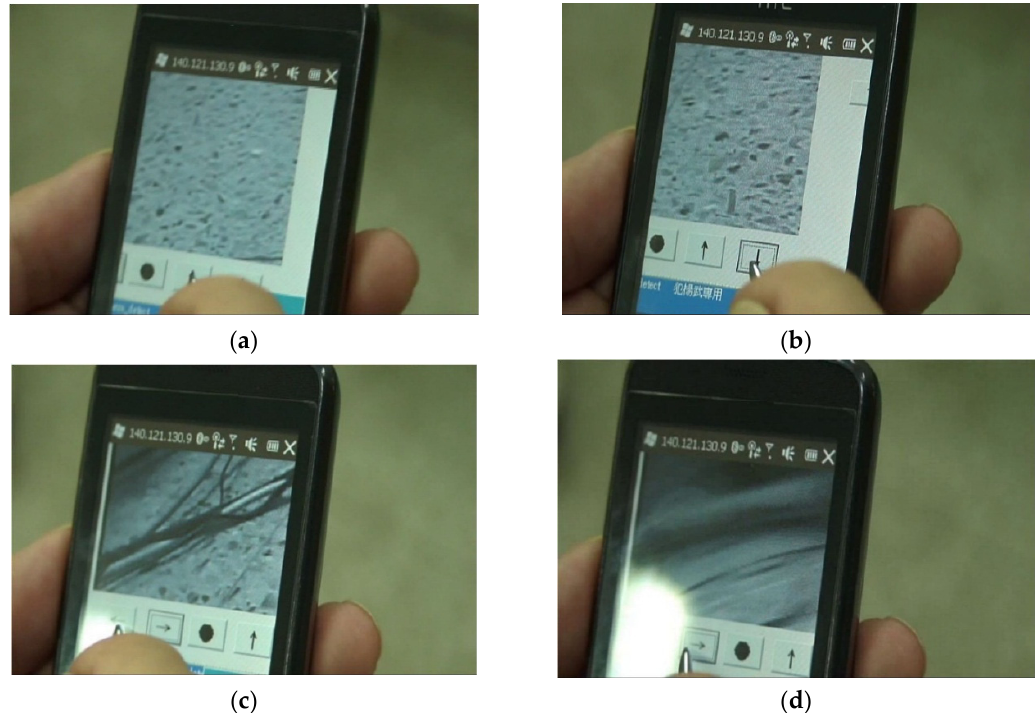
Figure 31. Captured images on smartphone. ( a ) Captured image at Figure 29a position; ( b ) Captured image at Figure 29b position; ( c ) Captured image at Figure 29c position; ( d ) Captured image at Figure 29d position.